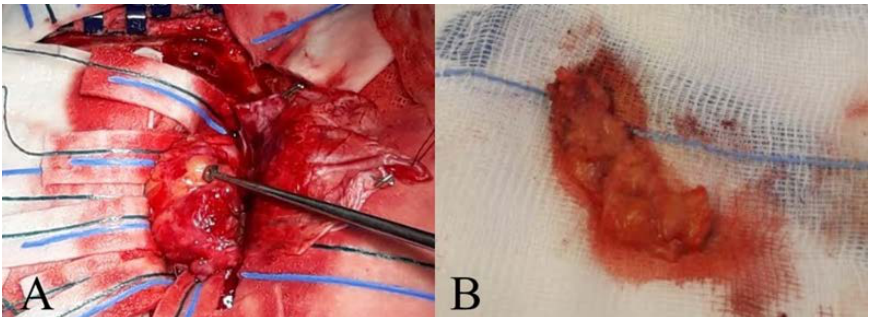
Figure 2. Intraoperative Photography. ( A ) A yellowish and rubbery lesion in appearance is noted. ( B ) Sample of meningioma for histological examination, after performing an “en bloc” resection. The histological examination showed a mixture of meningothelial lobules and adipo- cyte-like cells consistent with a lipomatous meningioma diagnosis (Figure 3).